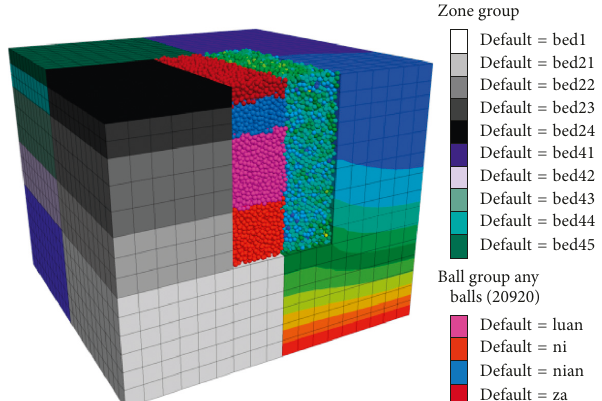
Figure 11: Model grouping and postequilibrium displacement change gram.